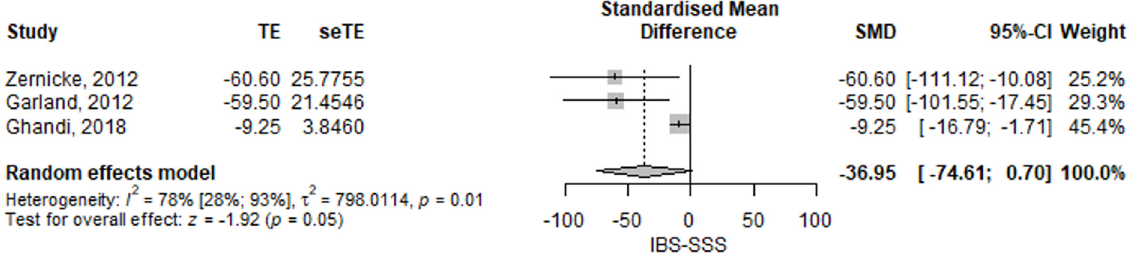
Figure 4. Irritable bowel syndrome—perceived stress standardized mean difference comparison between mindfulness intervention and control. IBS-PS, irritable bowel syndrome perceived stress; SMD, standardized mean difference; TE, treatment effect as SMD; seTE, standard error of the treatment effect; CI, confidence interval [15,17,21]. 3.2.4. Irritable Bowel Syndrome, Spiritual Scale The IBS observed spiritual scale score was higher in the mindfulness group com- pared to the control group [SMD = 2.8 (95% CI 1.01–4.6), p = 0.002] (Figure 5). The results had low heterogeneity, I 2 = 0%, p = 0.64. Figure 5. Irritable bowel syndrome the Functional Assessment of Chronic Illness Thera- py—Spiritual Wellbeing Scale (FACIT-sp) standardized mean difference comparison between mindfulness intervention and control. SMD, standardized mean difference; TE, treatment effect as SMD; seTE, standard error of the treatment effect; CI, confidence interval [15,17].